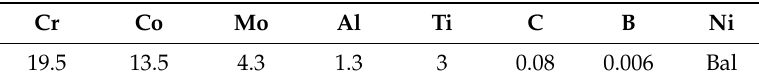
Table 1. Chemical Composition of Waspaloy (in wt %) [28]. Cr Co Mo Al Ti C B